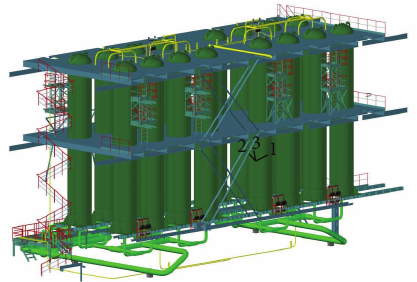
Figure 1: ECCS pressure